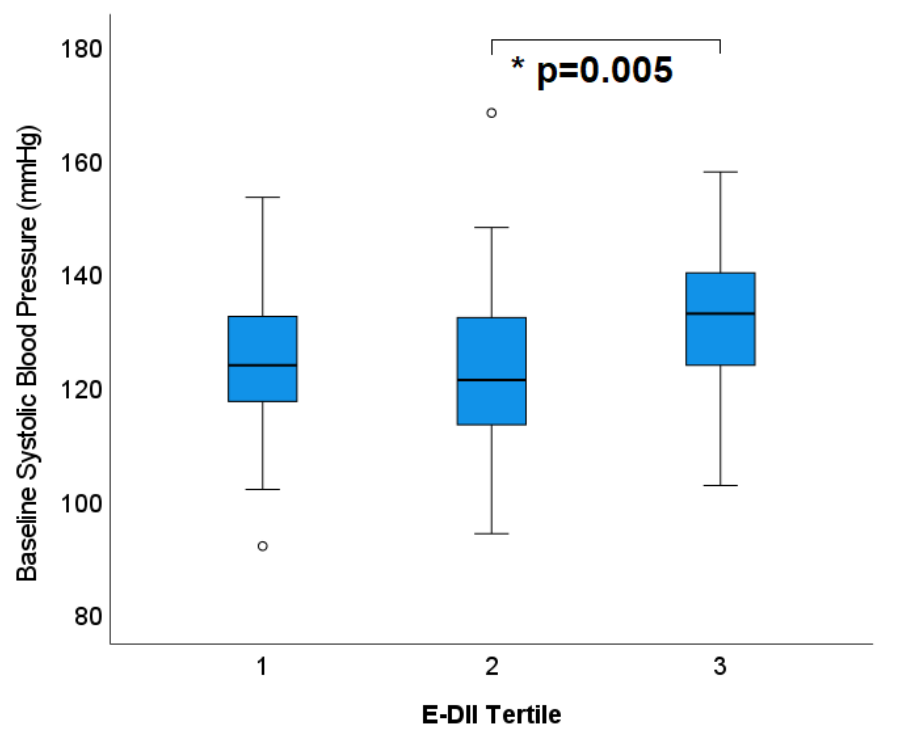
Figure 5. Tertiles of dietary inflammatory index (adjusted for energy) and systolic blood pressure at baseline; * p values represent statistical significance determine by LMEM. Circles outside error bars represent outliers. Table 2. Baseline values for MedLey outcome variables per DII tertile.